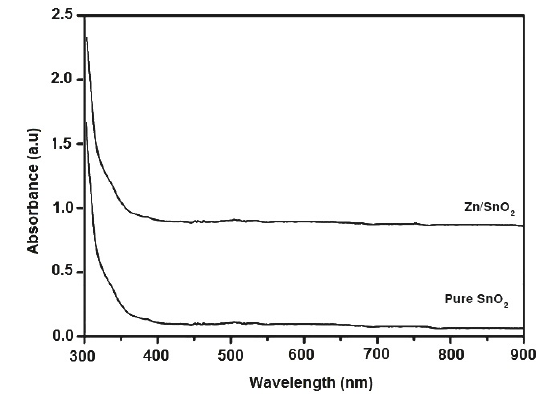
Fig.6. UV-Visible absorption spectrum of pure and Zn-doped SnO